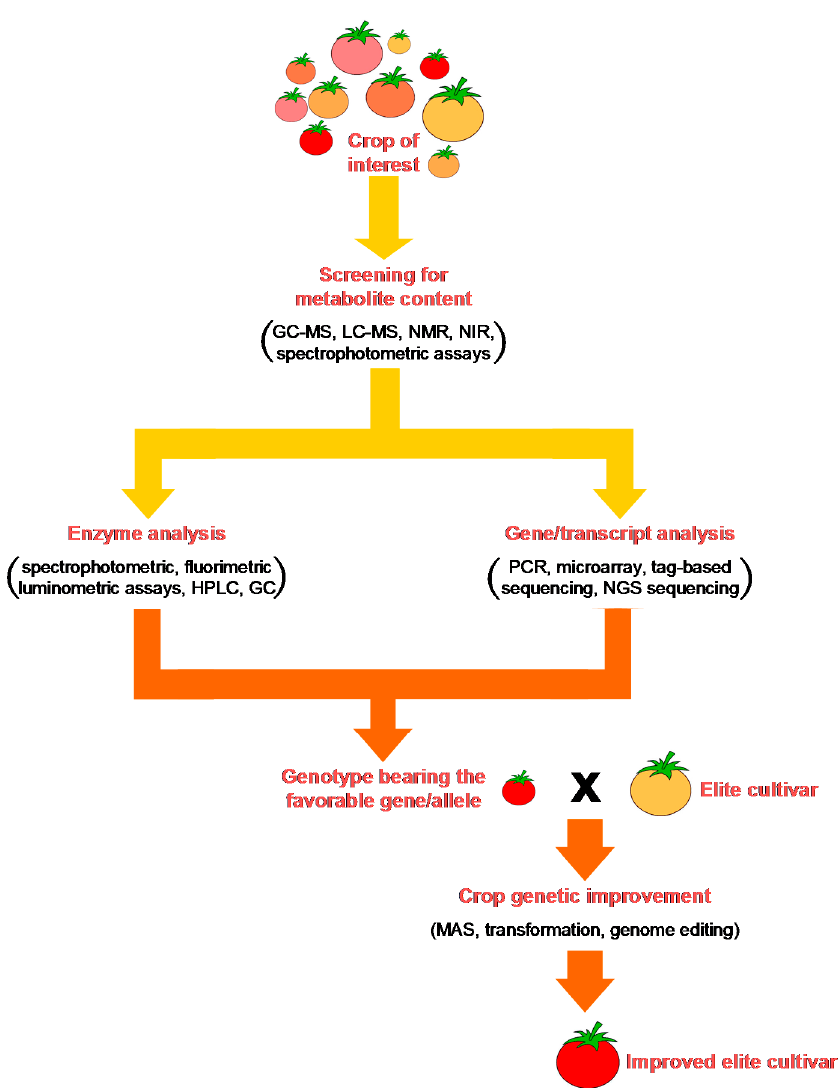
Figure 5. Outline of how a functional approach can contribute to identification of a candidate gene associated with high levels of a health-promoting phytochemical in a staple crop. A germplasm collection is screened to determine the variability in nature of the trait. Genotypes characterized by contrasting metabolite accumulation are subjected to enzymatic analysis to identify key enzyme variants (i.e., allozymes) that are characterized by contrasting activities/efficiencies, and molecular analysis to identify alleles that encode the different allozymes and to evaluate their expression levels. Then, on the basis of both the enzymatic and molecular information, a candidate gene/allele can be identified that can then be efficiently used in advanced breeding programs that are aimed at the introgression of the trait of interest into an elite cultivar.